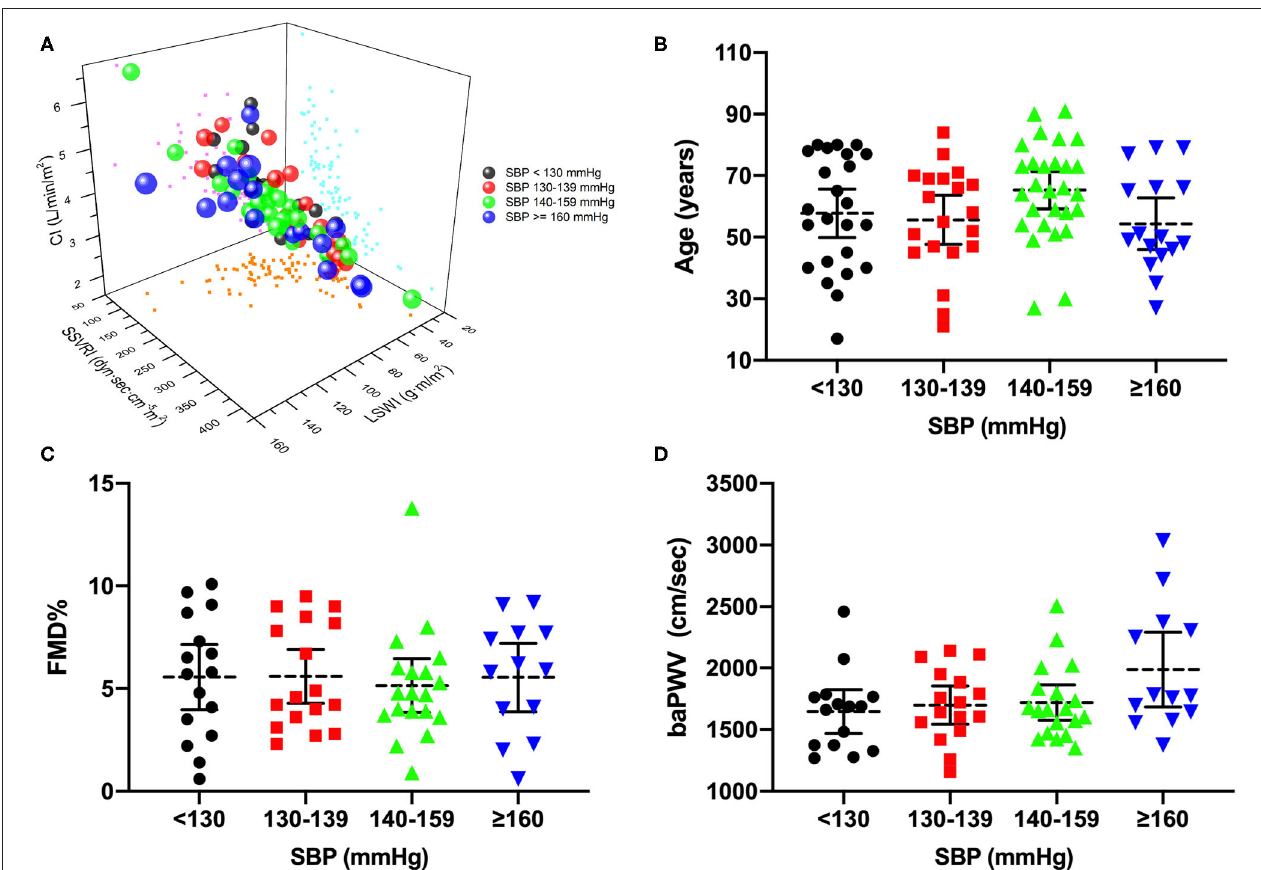
FIGURE 1 | Distribution of hemodynamic components and vascular function of hypertension. (A) Three-dimension scatterplot of CI, SSVRI, and LSWI by SBP categories, in which bubble size represents mean arterial pressure level. (B–D) Distinct distribution discrepancies of age, FMD, and baPWV in different blood pressure stages. CI, cardiac index; SSVRI, stroke systemic vascular resistance index; LSWI, left stroke work index; SBP, systolic blood pressure; FMD%, flow-mediated dilation percentage of baseline diameter; baPWV, brachial-ankle pulse wave